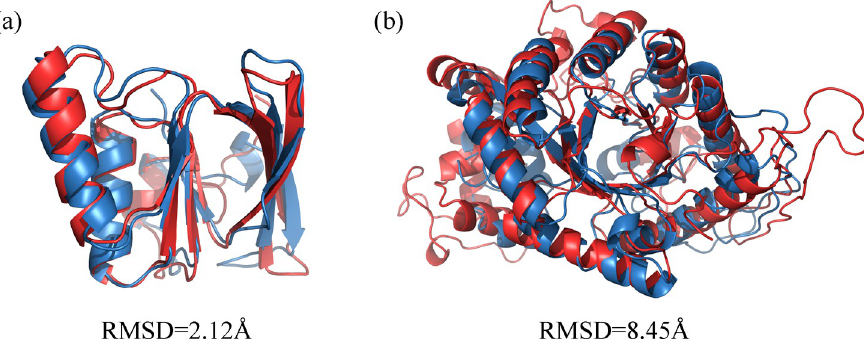
Fig 7. Protein structure superposition derived from the residue-level descriptors of GraSR. (A) SCOPe-sid: d1v59a2 (red) and d1h6va2 (blue) (B) SCOPe-sid: d5dqpa_ (red) and d1ezwa_